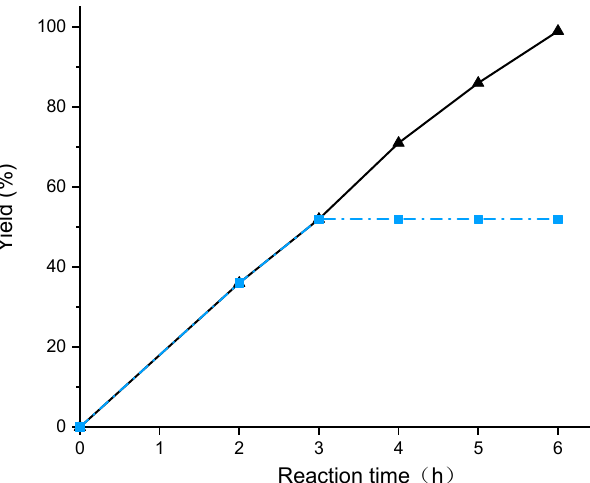
Figure 5. Time-dependent yields of the Suzuki–Miyaura cross-coupling reaction of bromobenzene with phenylboronic acid in the presence of Pd-NHC@Eu-BCI (solid line) or removal of Pd-NHC@Eu-BCI by filtration after 3 h reaction time (dashed line).